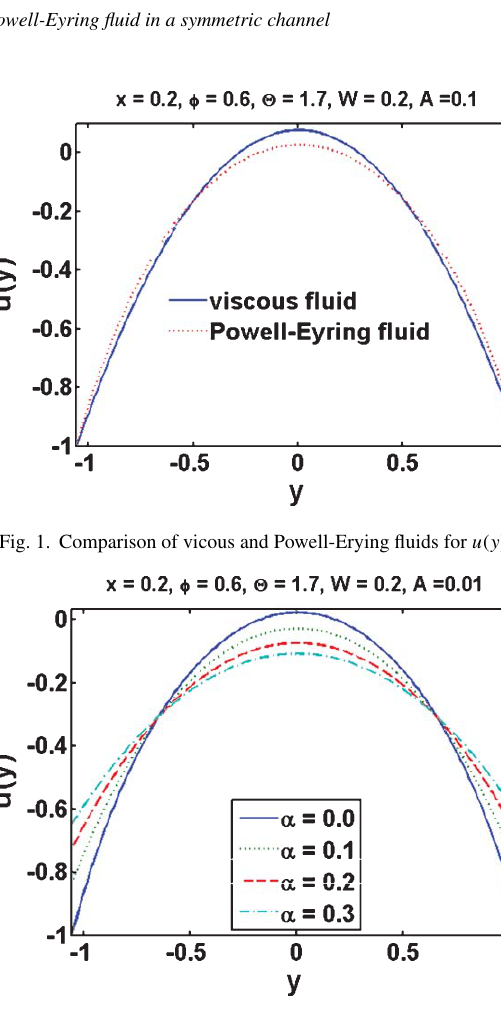
Fig. 2. Variation in u ( y ) against y for different values of slip param- eter ( α ).